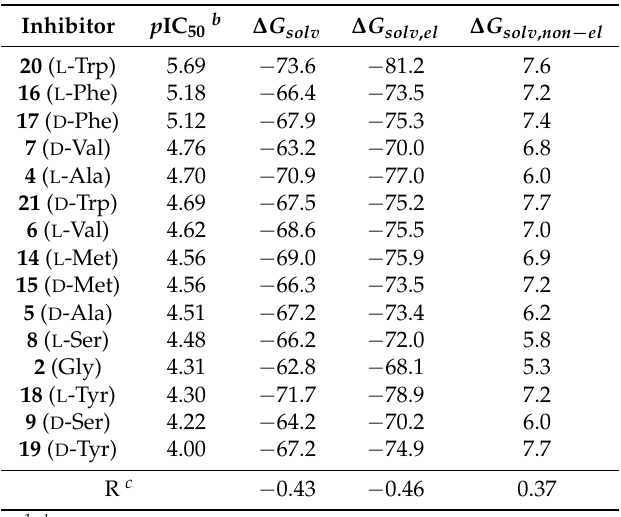
∆ G solv , non − el , contributions